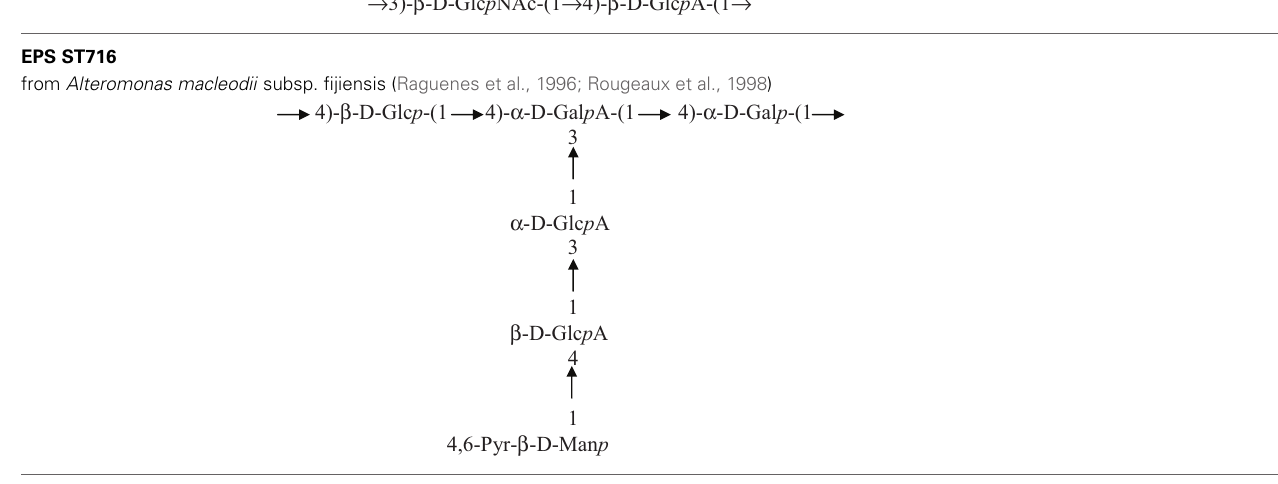
Table 2 | Repeating unit chemical structures of main glycosaminoglycans and of some marine exopolysaccharides. Heparin antithrombin-binding site pentasaccharide (Choay et al., 1983) → 4)- α -D-GlcN p 2S6S-(1 → 4)- β -D-GlcA p -(1 → 4)- α -D-GlcN p 2S3S6S-(1 → 4)- α -L-IdoA p 2S-(1 → 4)- α -D-GlcN p 2S6S-(1 → Hyaluronic